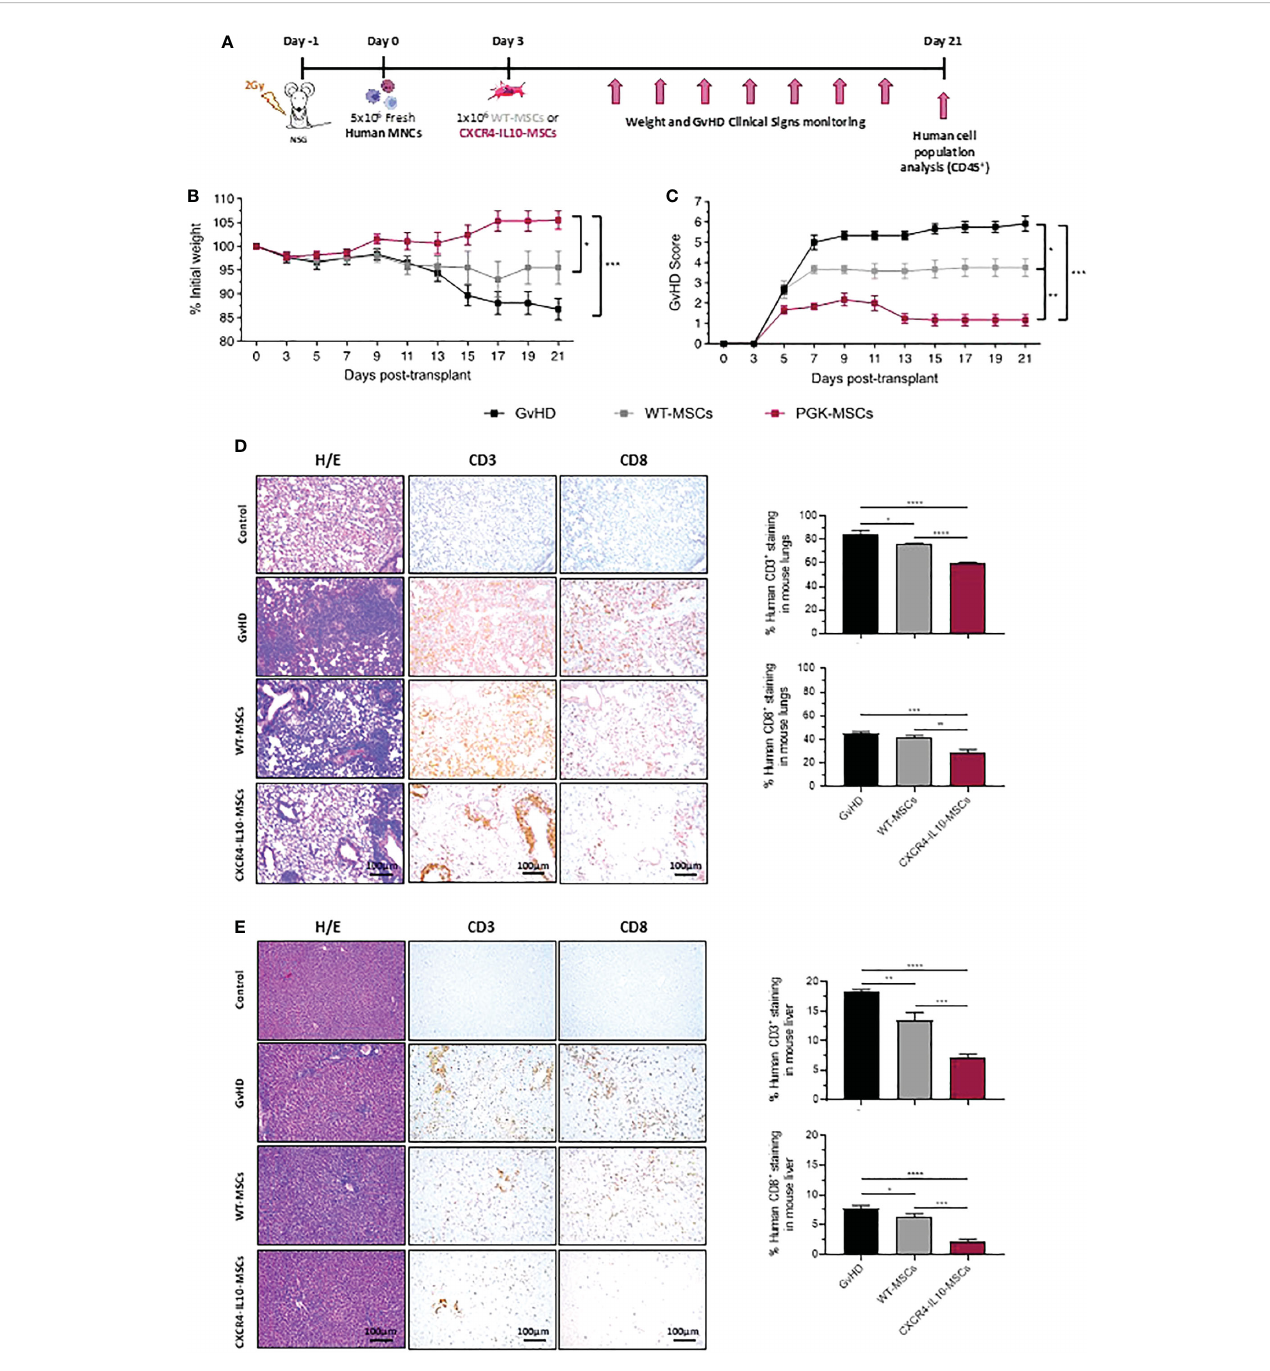
FIGURE 3 Enhanced therapeutic ef fi cacy of CXCR4-IL10-MSCs in a humanized model of GvHD. (A) Schematic diagram of the humanized GvHD model generated in NSG mice. (B) Weight kinetics of NSG mice transplanted with hMNCs and treated with WT- or CXCR4-MSCs three days later. (C) GvHD clinical score in NSG transplanted recipients treated with WT- or CXCR4-IL10 MSCs. The GvHD score was deduced from analyses of the weight loss, and evaluation of posture, activity, hair texture, skin integrity, and presence of diarrhea of transplanted mice (See materials and methods). (D) Histopathological analysis of lung sections from NSG recipients treated with WT- or CXCR4-IL10-MSCs three weeks after NSG mice transplantation. Pictures correspond to representative images of H/E staining and of immunohistochemical staining with anti-hCD3 and anti-hCD8 monoclonal antibodies. Right panels represent the percentage of hCD3 + and hCD8 + T cells identi fi ed in the lung slides. (E) Histopathological analysis of liver sections from NSG recipients treated with WT- or CXCR4-IL10-MSCs. Studies are equivalent as those conducted in lungs. Each bar represents the mean ± SEM of data from 5-6 mice per group. *p < 0.05; **p < 0.01; ***p < 0.001; **** p <0.0001. Control: healthy non-treated